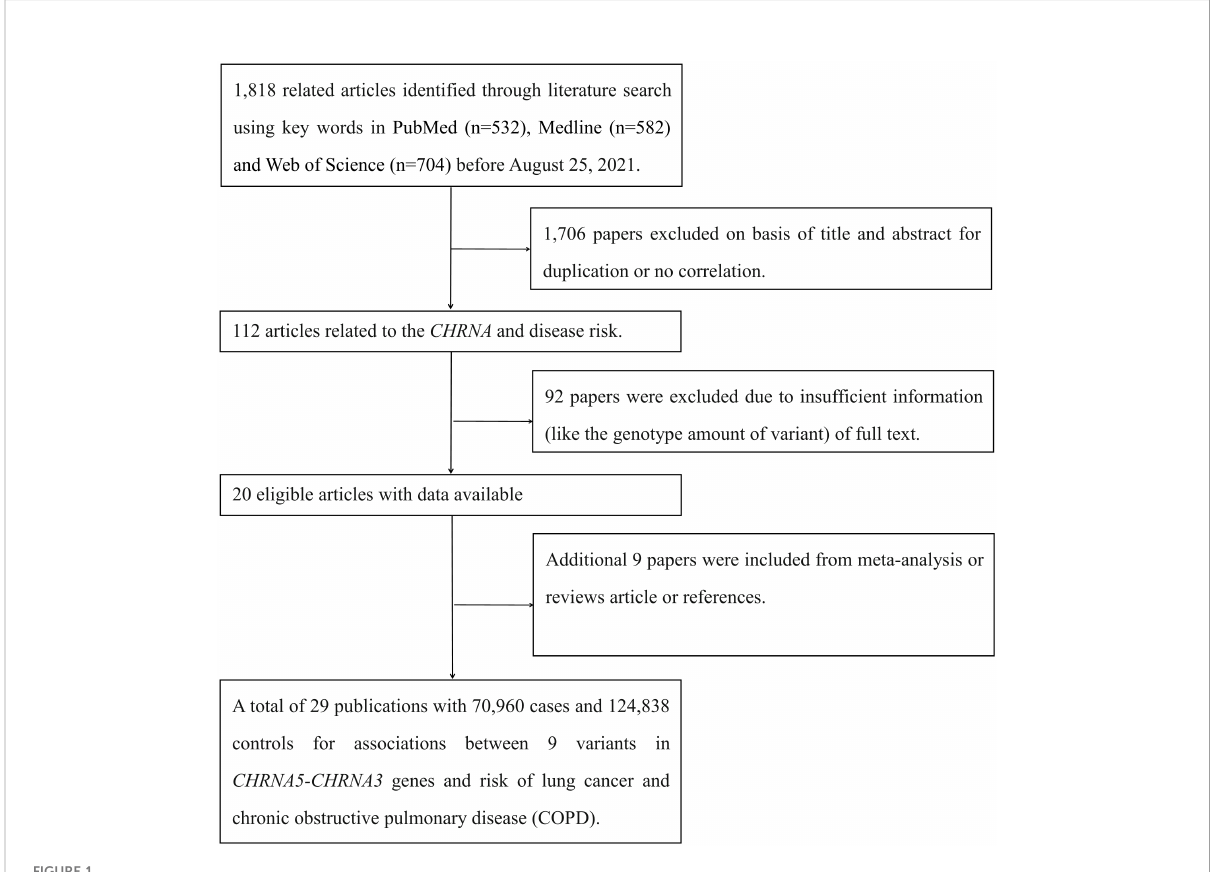
FIGURE 1 Flow diagram of literature search and study